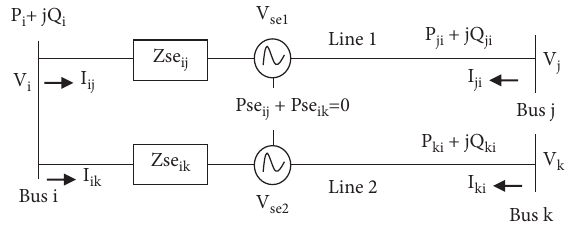
Figure 1: Equivalent circuit of